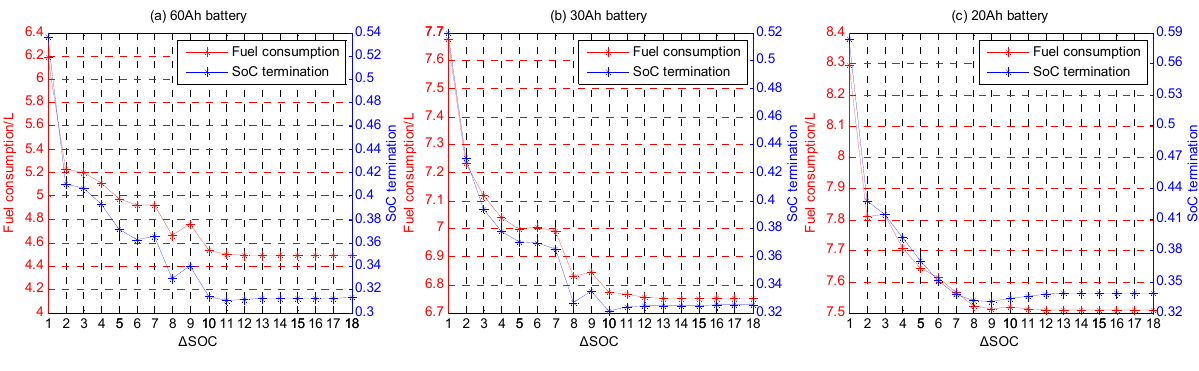
Figure 11. The results calculated by DP with different SoC  .